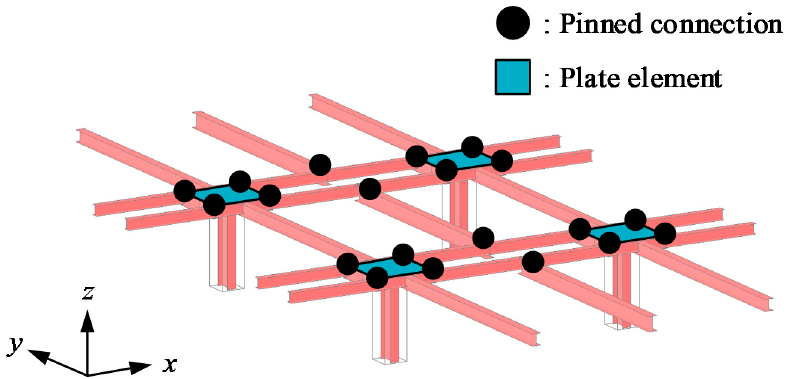
Figure 5. Connection modeling of the steel double-beam floor system with the concrete